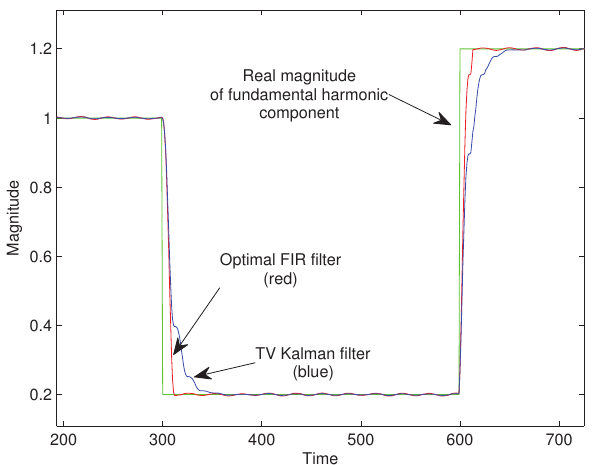
Figure 5. Estimated magnitude of the fundamental component with Q / R = 0.025.